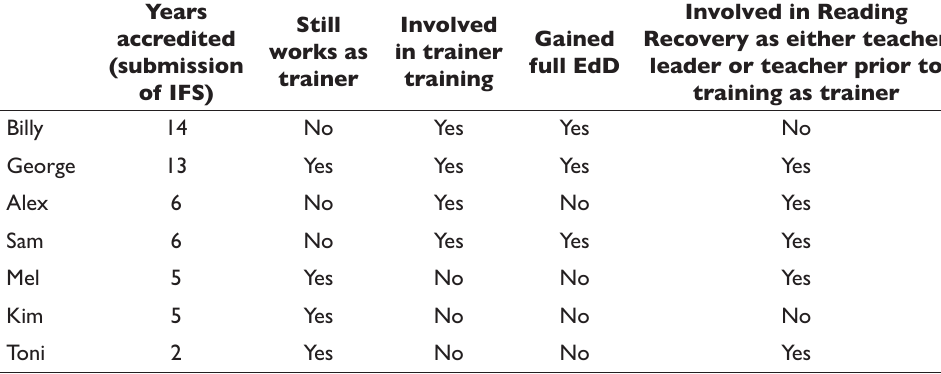
Table 2: Participant